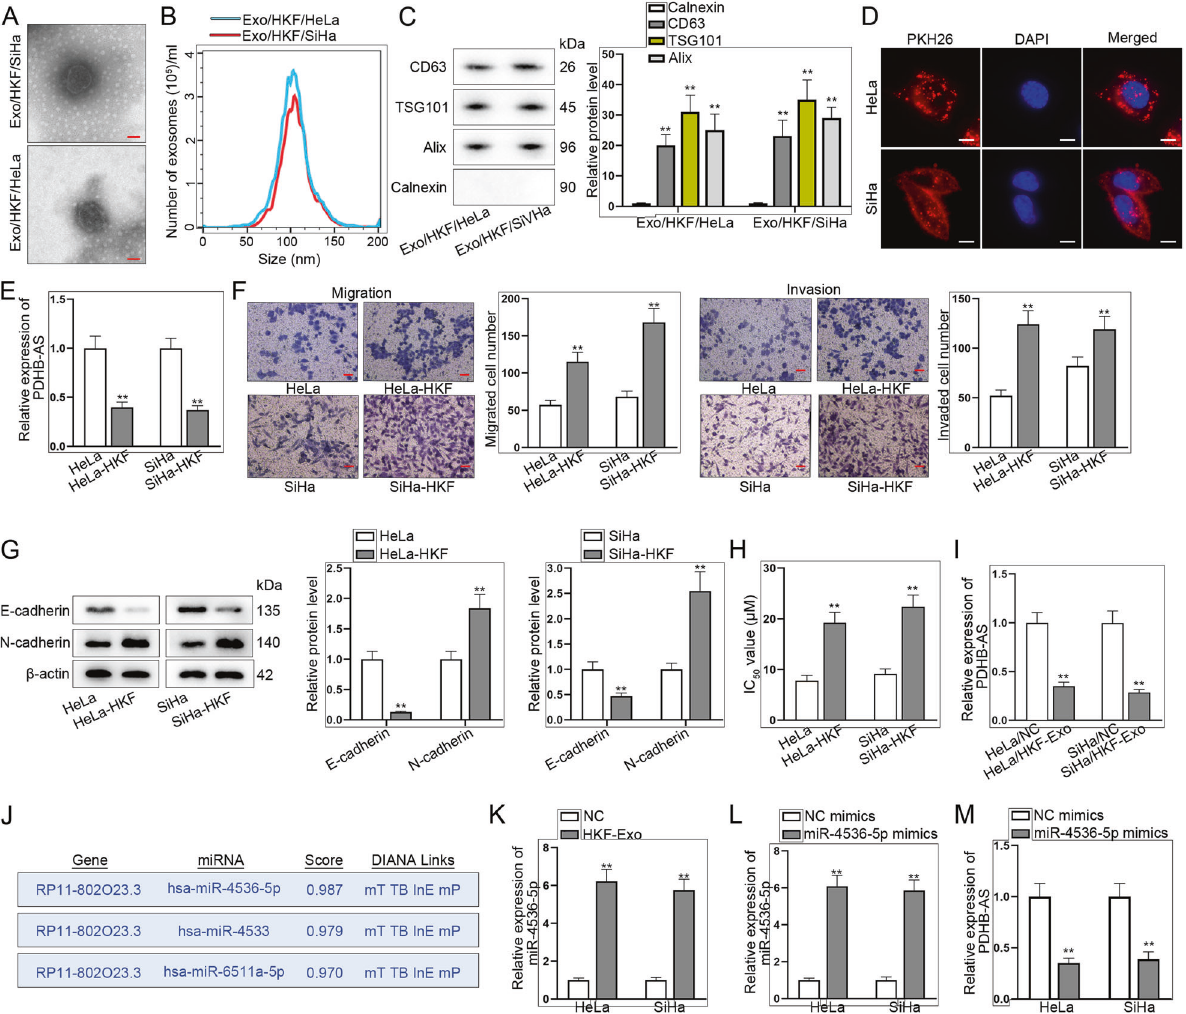
Fig. 2 HKF-derived exosomes carry miR-4536-5p and enter CC cells to interfere PDHB-AS expression. A Images of exosomes were observed with an electron microscope. B Exosome size was analyzed with NTA. C Western blot was used to detect exosome marker